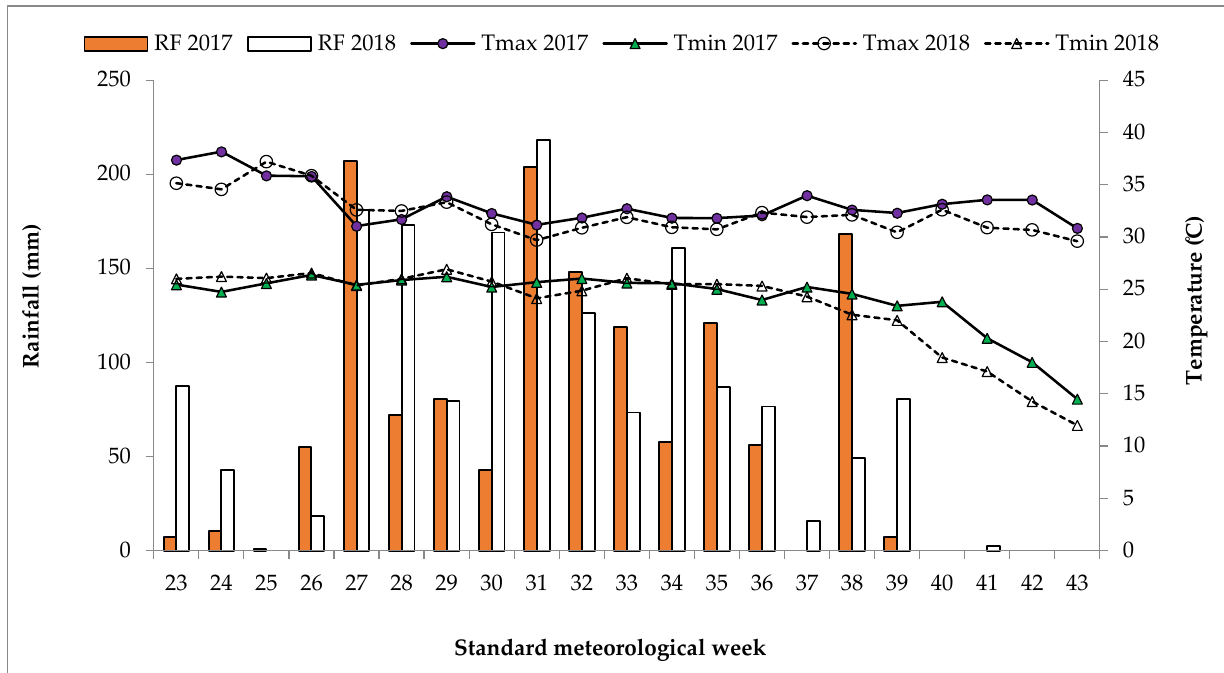
Figure 1. Standard meteorological weekly variation in the weather during the crop growing season.